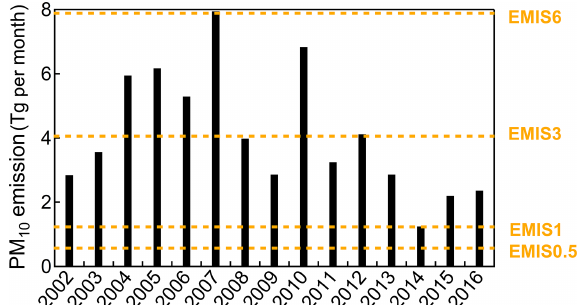
Figure 2. Annual variation in PM 10 emission during September over domain1 based on